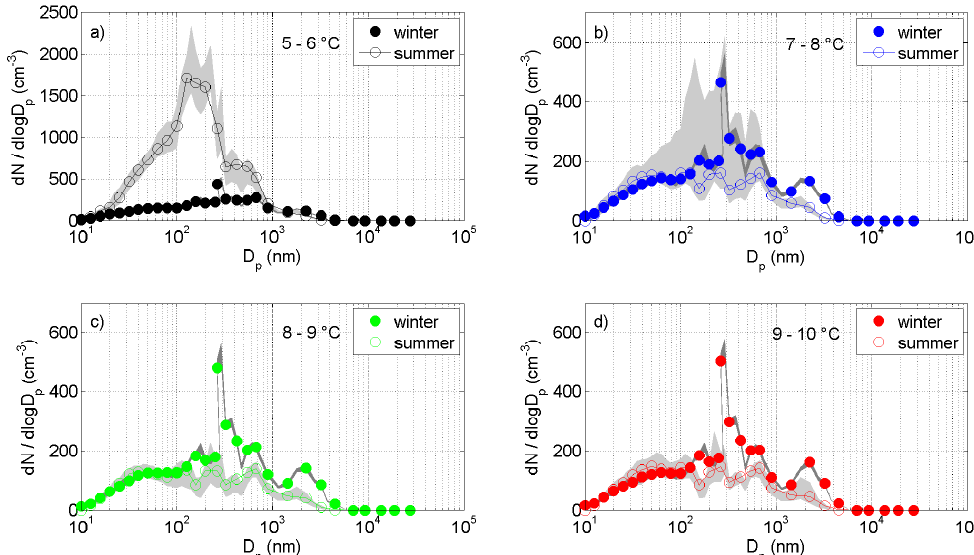
Fig. 4. Comparison of particle number size distributions resulting from water sampled close to the glacier during summertime and wintertime, for the same water temperature ranges of (a) 5–6 ◦ C, (b) 7–8 ◦ C, (c) 8–9 ◦ C and (d) 9–10 ◦ C. For clarity only every second data point is shown. Grey shaded areas represent the interquartile ranges. Note the different scale for the lowest temperature range.